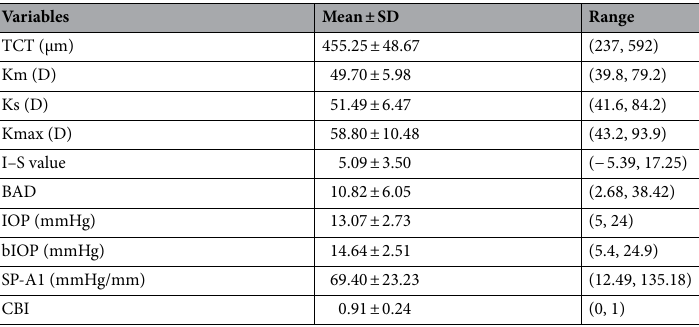
Table 1. The clinical data of 430 KC eyes. TCT thinnest corneal thickness, Km mean keratometry, Ks steep keratometry, Kmax the maximum keratometry, IS-Value inferior-superior value, BAD Belin Ambrósio